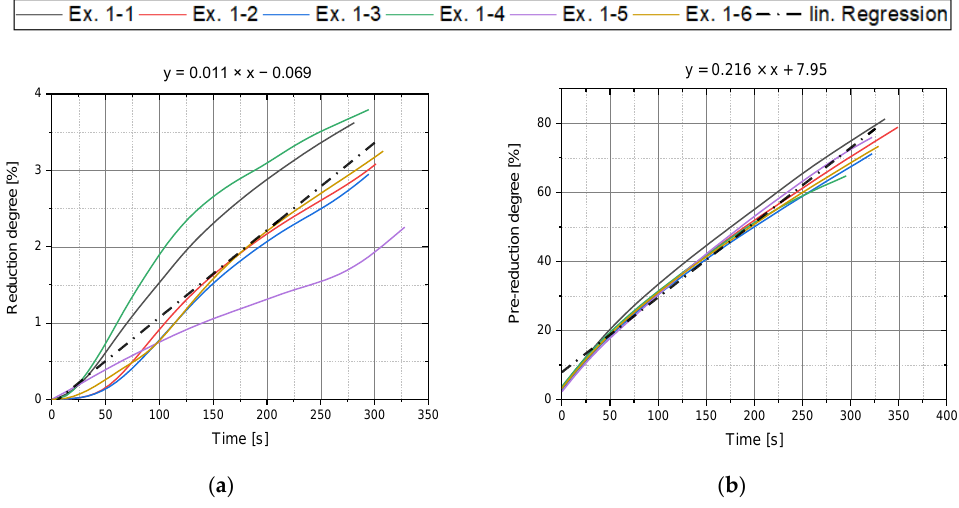
Figure 3. Reduction trend Ex. 1 – 3 with the associated procedure steps from chapter 2.2. In the pre-melting phase, oxygen removal through thermal decomposition of hema- tite to magnetite occurred with pure argon and reduction degrees of approximately 3.5% were achieved. The comparison of the pre-melting procedure of the first preliminary se- ries (Ex. 1 – 1 to Ex. 1 – 6) can be seen in Figure 4a. Another objective of the preliminary trials was to determine the necessary pre-reduction time to obtain specific degrees for the main trials. For this purpose, the progressions of the individual experiments were determined and a regression line was created, (Figure 4b), to subsequently calculate the required time.